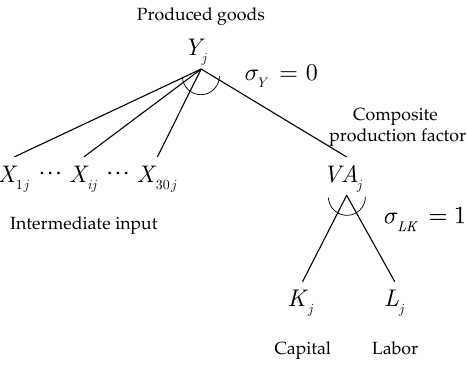
Figure 2. Structure of the production sector. Table 2. Sector